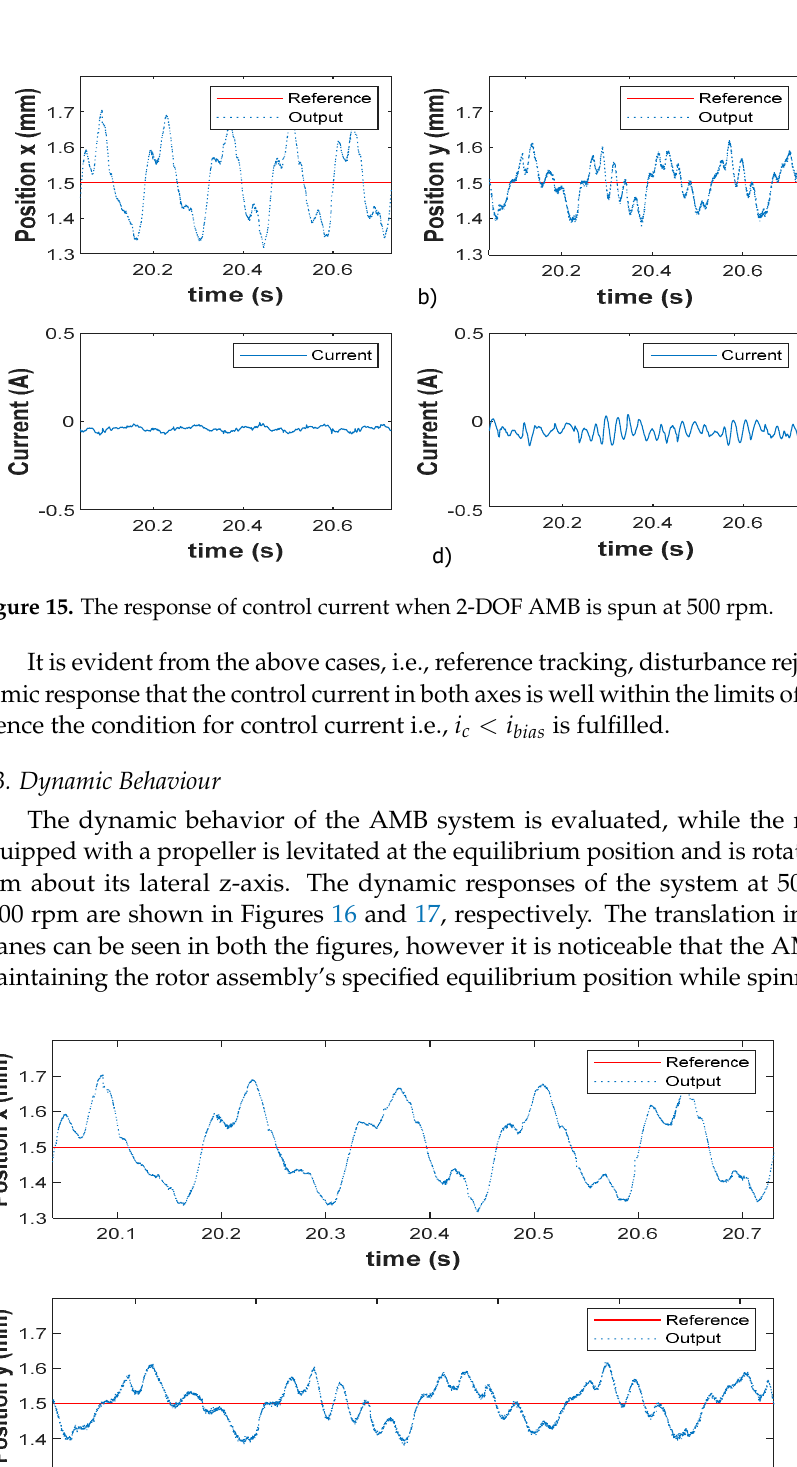
Figure 14. The response of control current during reference command tracking of AMB system in both x and y planes.